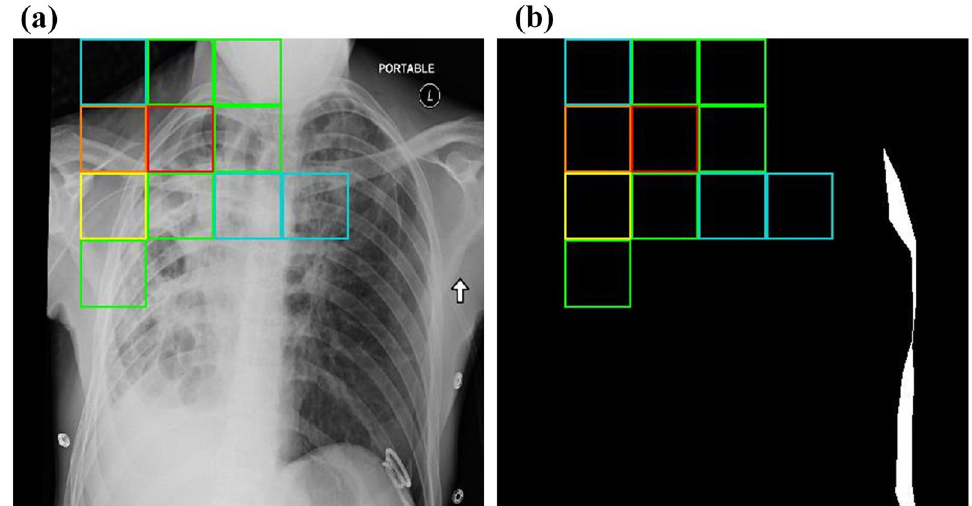
Figure 4. Example of inaccurately predicted pneumothorax location. The location of pneumothorax predicted by a small artificial neural network is indicated by colored boxes. ( a ) Original chest X-ray image. ( b ) Image obtained after marking the location of pneumothorax in white and the remaining areas in